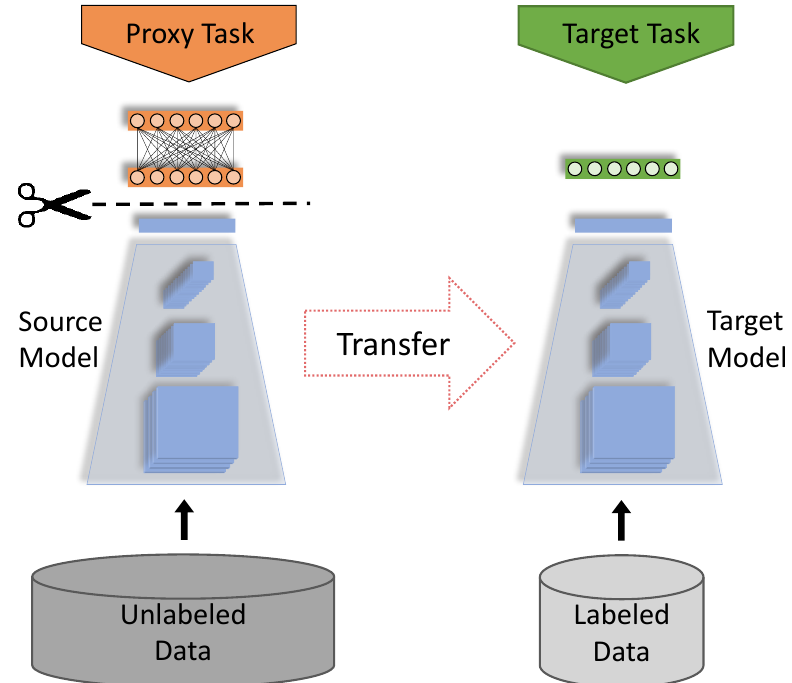
Figure 1. Flowchart of self-supervised learning stages. First, a deep learning model, e.g., CNN, is trained on unlabeled data using a proxy task. Then, the obtained knowledge (representations) is transferred into a target downstream